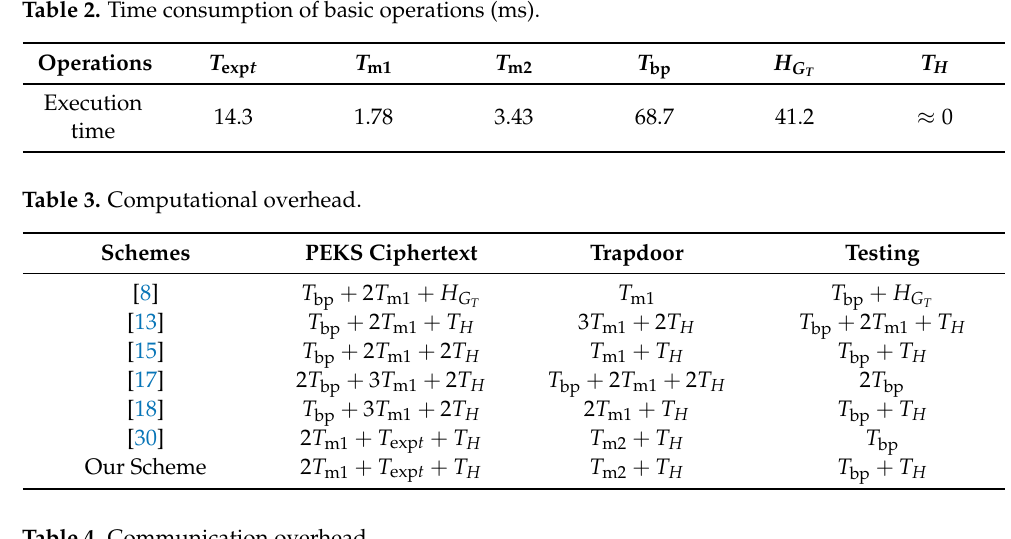
Table 4. Communication